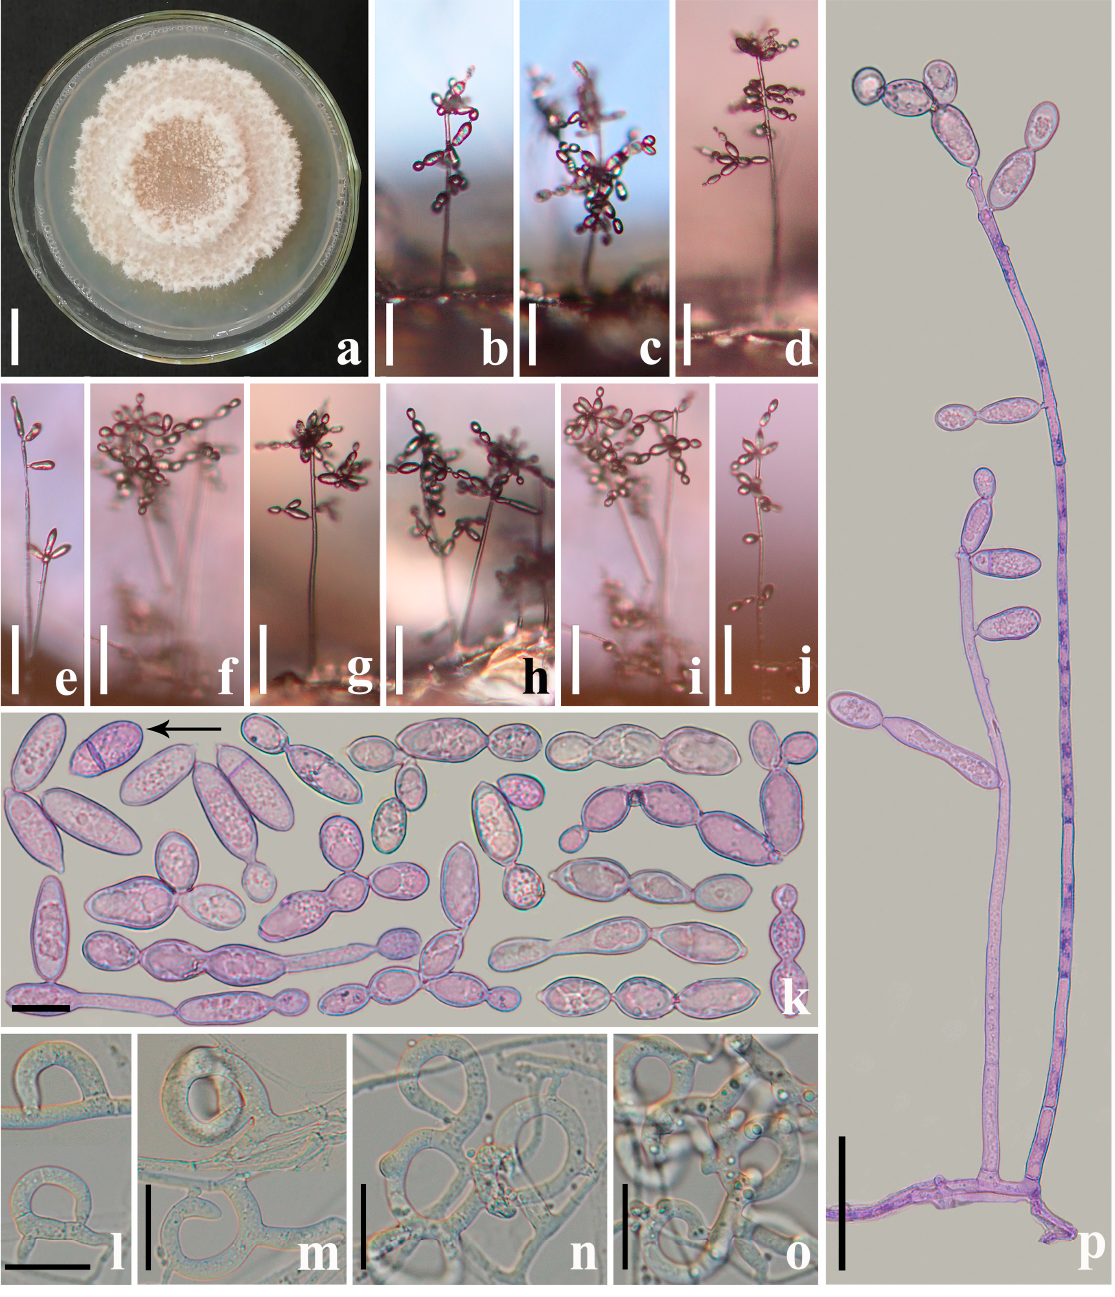
Figure 2. Arthrobotrys blastospora (CGMCC 3.20940). ( a ) Colony; ( b – j ) Conidiophores and blastospores; ( k ) Blastospores; ( l – o ) Trapping structure: adhesive networks; ( p ) Conidiophores. Scale bars: ( a ) = 1 cm; ( b – j ) = 10 µm; ( k – o ) = 20 µm; ( p ) = 100 µm.